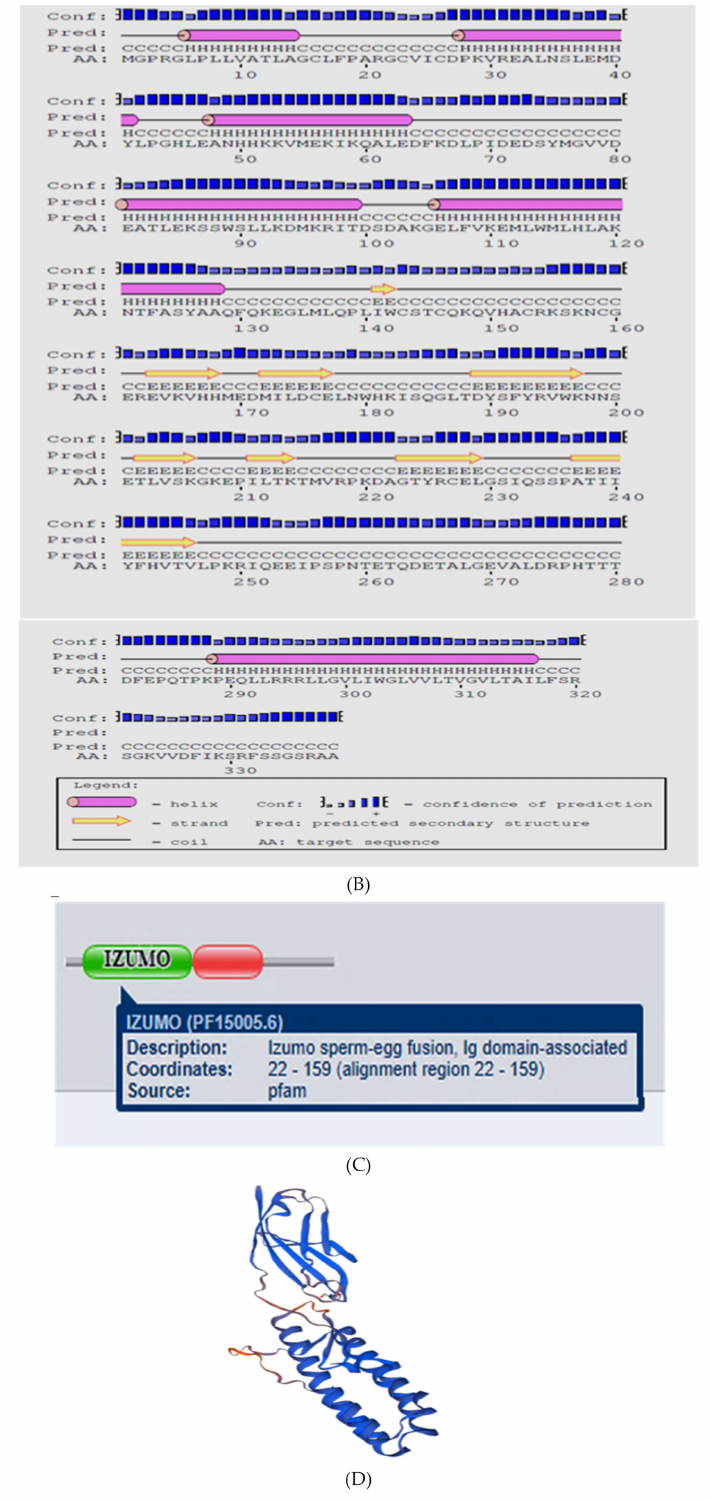
Figure 4. Bioinformatics analysis and prediction of protein sequence encoded by IZUMO1 from the testis of Datong yak. The protein encoded by yak IZUMO1 contains an immunoglobulin (Ig) domain-associated. ( A ) Predicted protein and DNA sequences of yak IZUMO1 gene. ( B ) Predicted secondary structure of IZUMO1 protein. ( C ) Predicted conserved domain for IZUMO1 protein. ( D ) Predicted three dimensional structure of protein encoded by IZUMO1